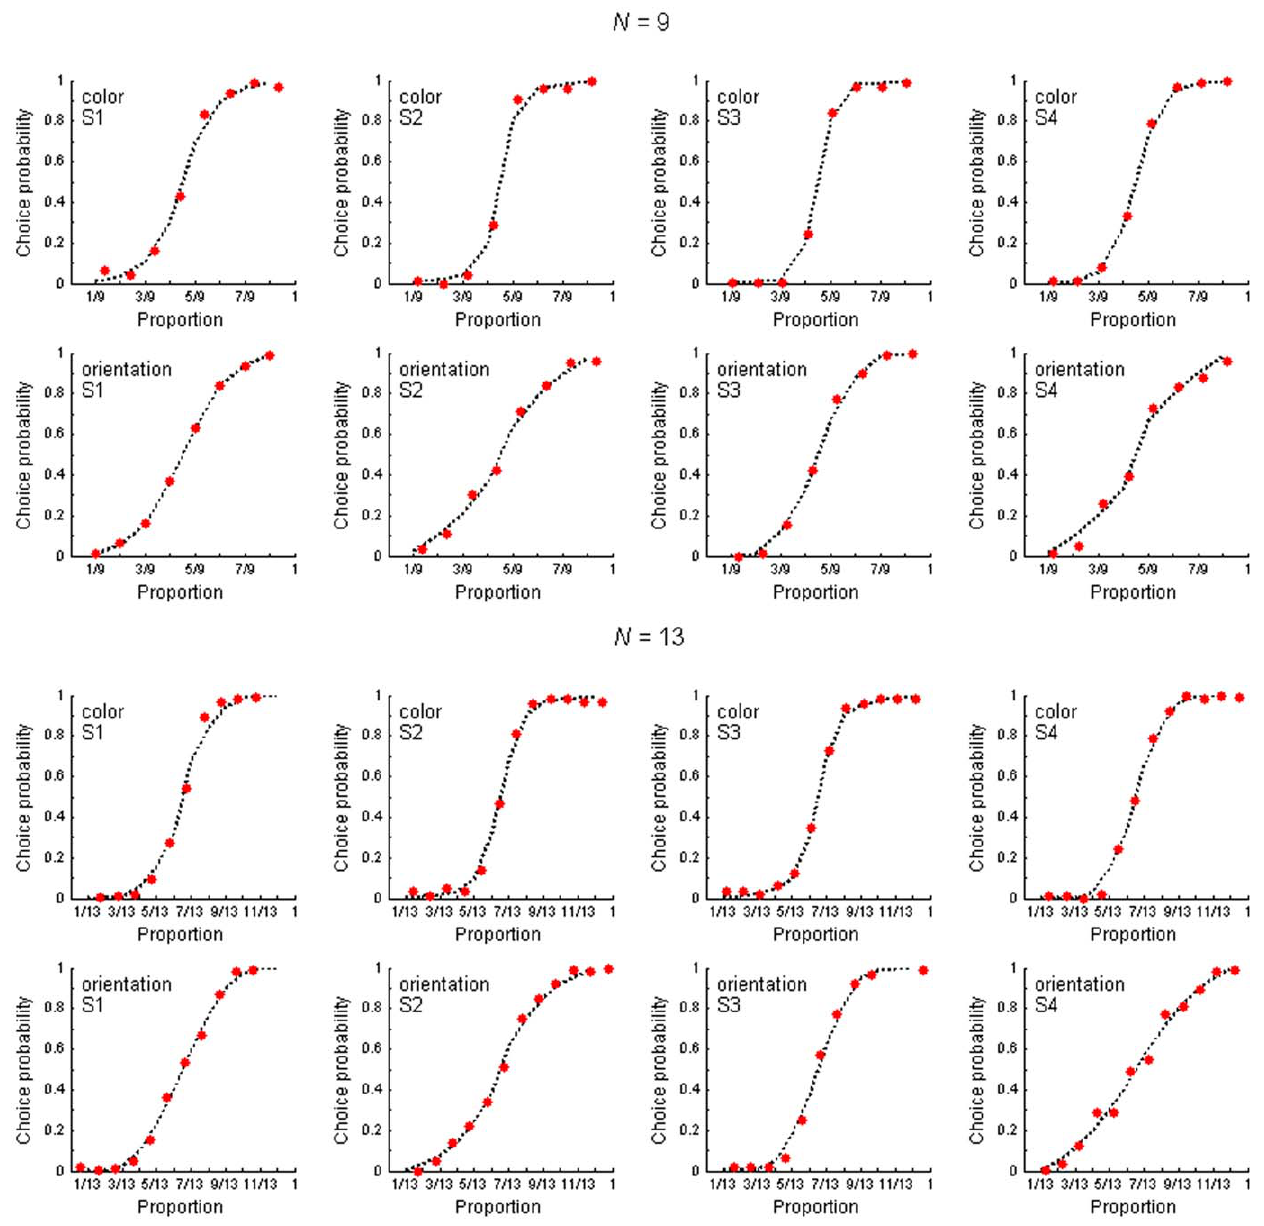
Figure 2. The best fitting theoretical models (dotted line) vs empirical results (red points). The choice probability as a function of the proportion of the chosen response category for four observers, two discrimination tasks (color and orientation), and two numbers of elements ( N =9 and 13). Each point is a probability estimate computed from 100 trials. The dotted line represents the best fitting theoretical mixture model shown in Tables 1.A and